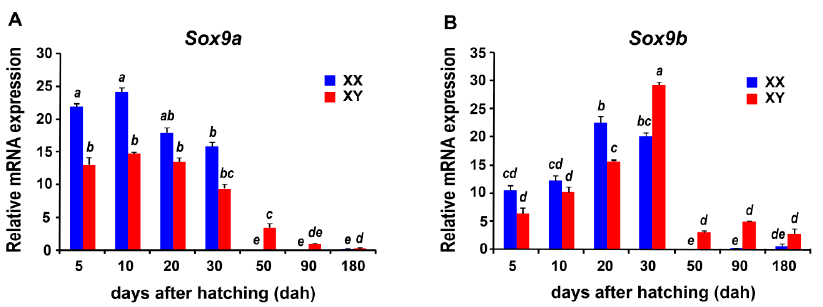
Figure 7. Quantitative RT-PCR examination of the Sox9a ( A ) and Sox9b ( B ) expressions in the XX and XY gonads of the tilapia. The quantitative RT-PCR experiment was performed in triplicates using pooled monosex fish cDNAs in each of the selected developmental stages. Values represent the relative mRNA expression in relation to the internal control ( β -actin gene). Data were expressed as the mean ± SD of the triplicates. Column error bars with the same letter are not significantly different at p < 0.05 as determined using Least Significant Difference (LSD) test.